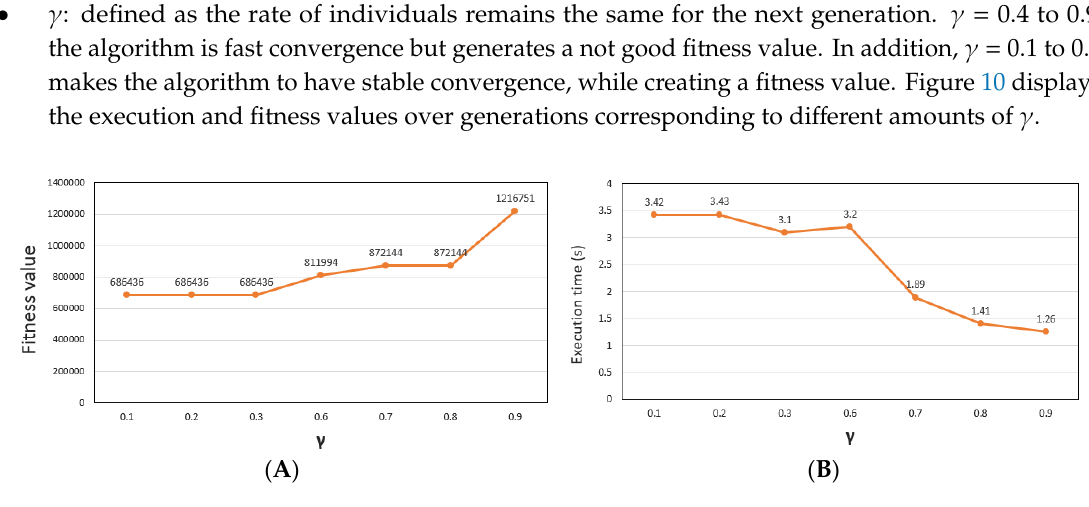
Figure 10. ( A ) the fitness values over generations; ( B ) the execution times over generations.